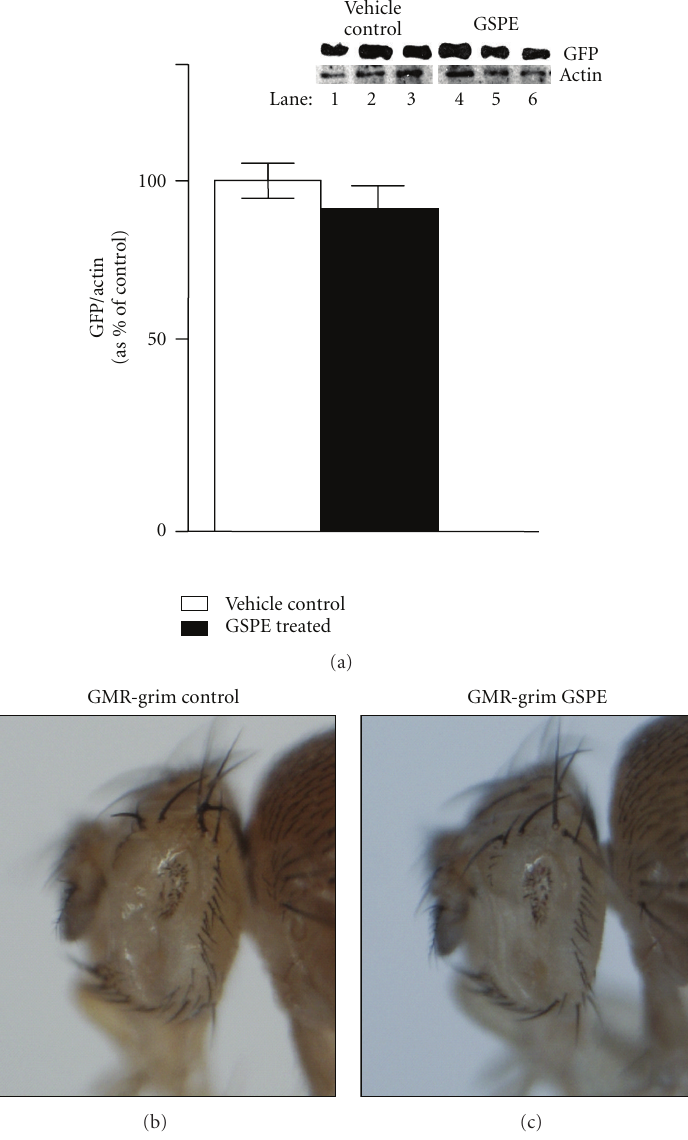
Figure 2: GSPE does not inhibit Gal4-mediated expression of GFP . (a) Western-blot analysis of lysates from TubGal4 > GFP flies (created by crossing TubGal4 flies to UAS-GFP flies) reared from egg deposition either on food supplemented with water (vehicle control) (Lanes 1–3) or reared on GSPE food (lanes 4–6). Each lysate was prepared from 6 fly heads, and three independent groups of 6 flies per group (lane) are shown. The same immunoblot was probed first with antibodies raised against GFP (upper panel) and then immunoblots were stripped and reprobed with antiactin antibodies (lower panel). (b) GMR-grim flies have very small, almost absent eyes when reared on control food. (c) Eye size is not a ff ected when GMR-grim flies are reared on GSPE